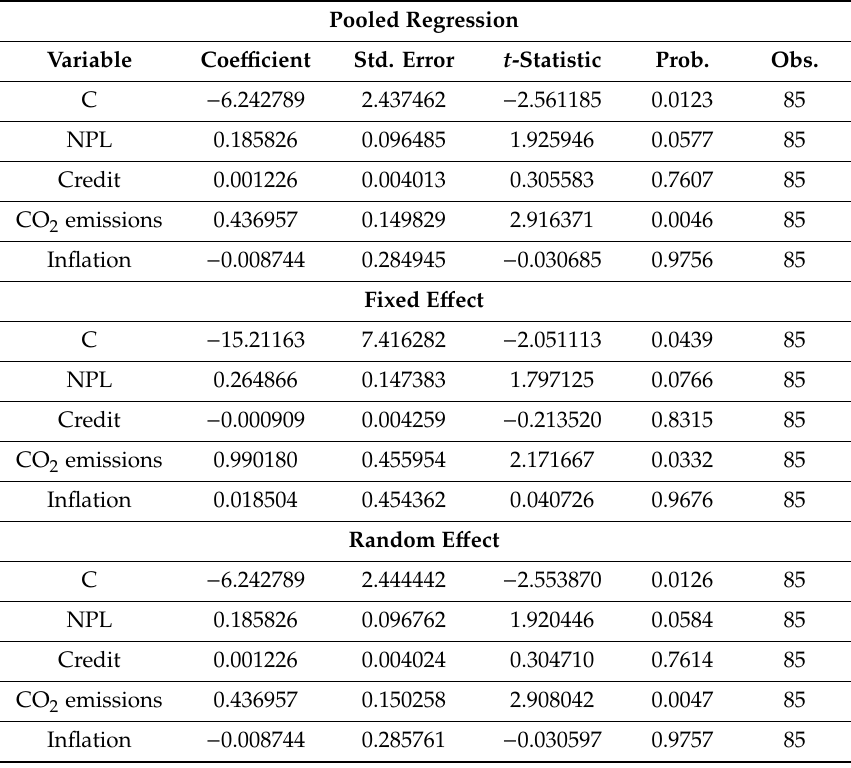
Table 2. Pooled regression model, fixed e ff ect model, and random e ff ect model. Pooled Regression Variable Coe ffi cient Std.